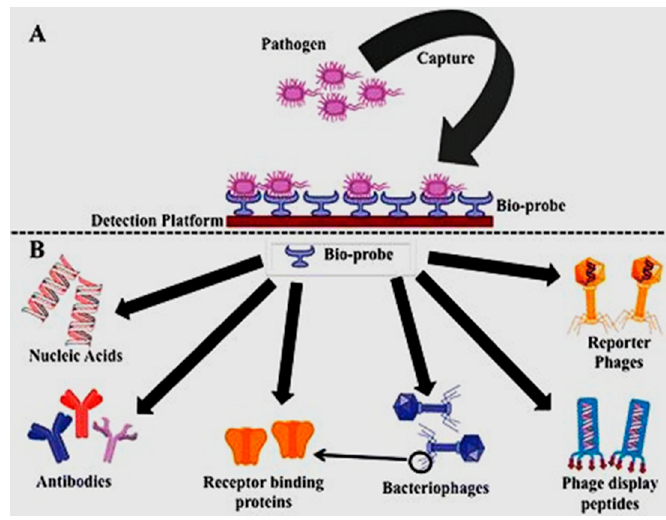
Figure 5. ( A ) Capturing the pathogen on the sensing platform; and ( B ) varieties of bio-probe surface for pathogen detection [70].